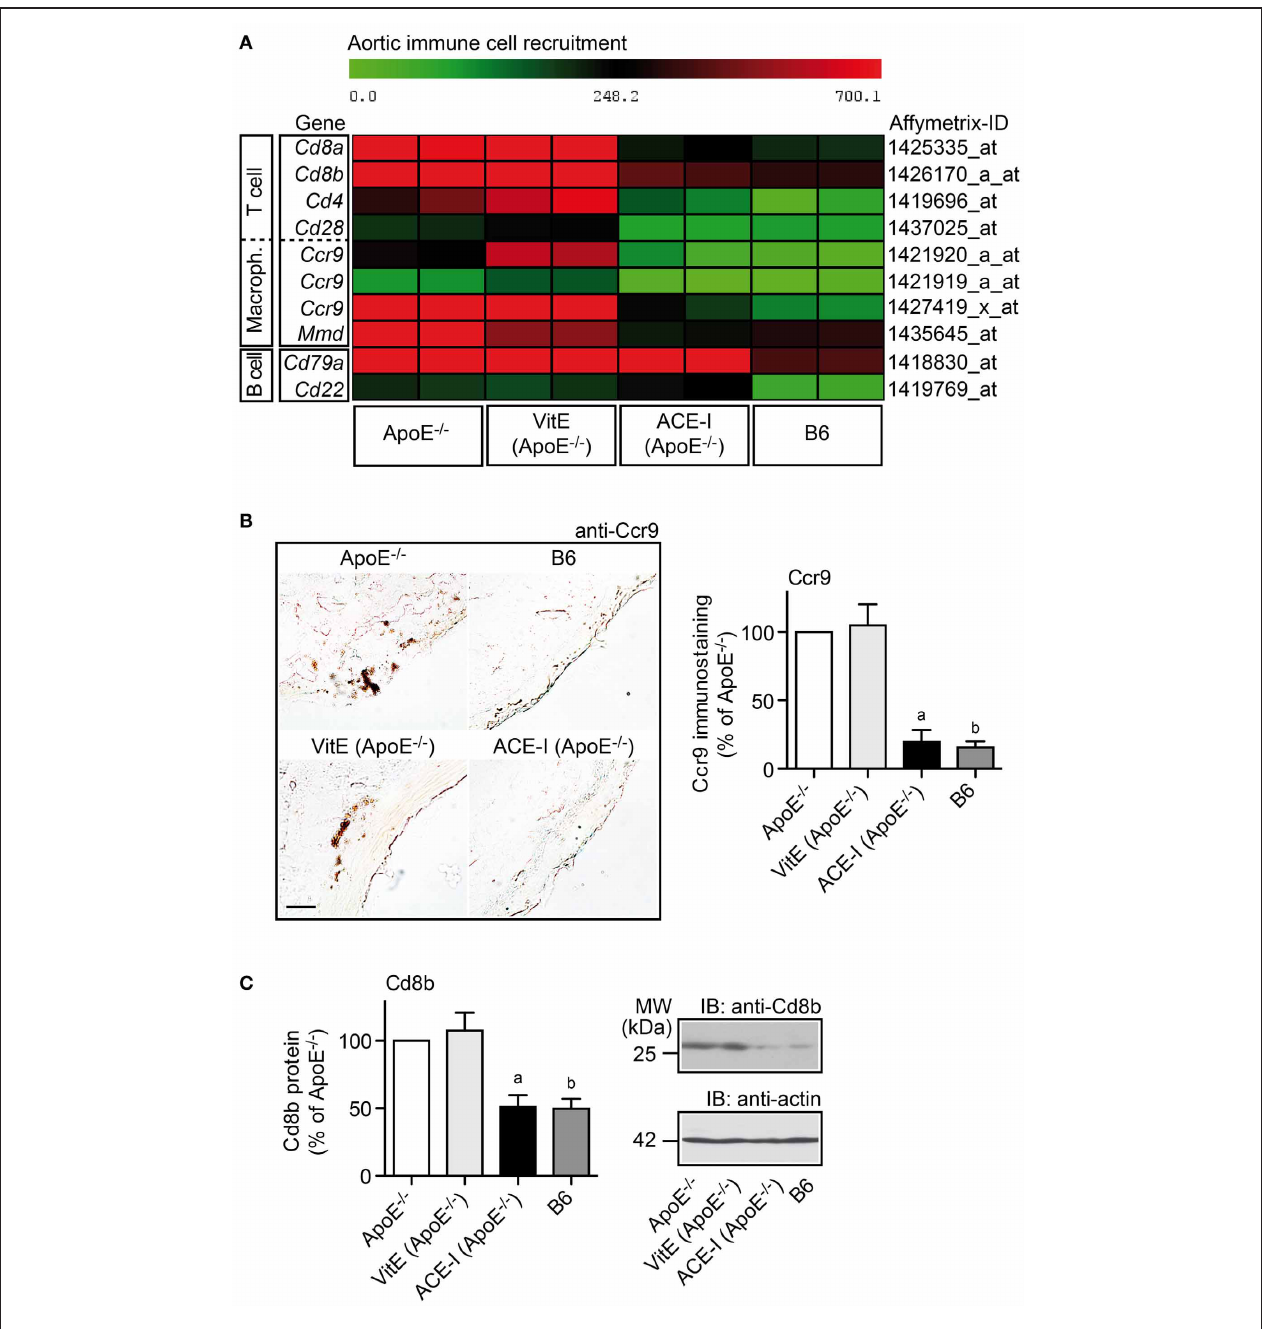
Left panels: immunohistological detection of Ccr9-positive aorta-infiltrating immune cells of a 32-week old ApoE − / − mouse and an age-matched vitamin E-treated ApoE − / − mouse confirmed microarray gene expression data. Ccr9-positive cells were not detected in the aorta of a B6 control and an ACE-inhibitor-treated ApoE − / − mouse (bar: 25 μ m). The right panel shows quantitative evaluation of immunohistology data from four mice each ( ± s.d.; n = 4; a P = 0 . 0004; b P = 0 . 0001 vs. ApoE − / − ). (C) Left panel: immunoblot quantification of aortic Cd8b protein content of 32-week old ApoE − / − mice, age-matched vitamin E-treated, or ACE-inhibitor-treated ApoE − / − mice, and B6 control mice ( ± s.d.; n = 4; a P = 0 . 0015; b P = 0 . 0009 vs. ApoE − / − ). The right panels show representative